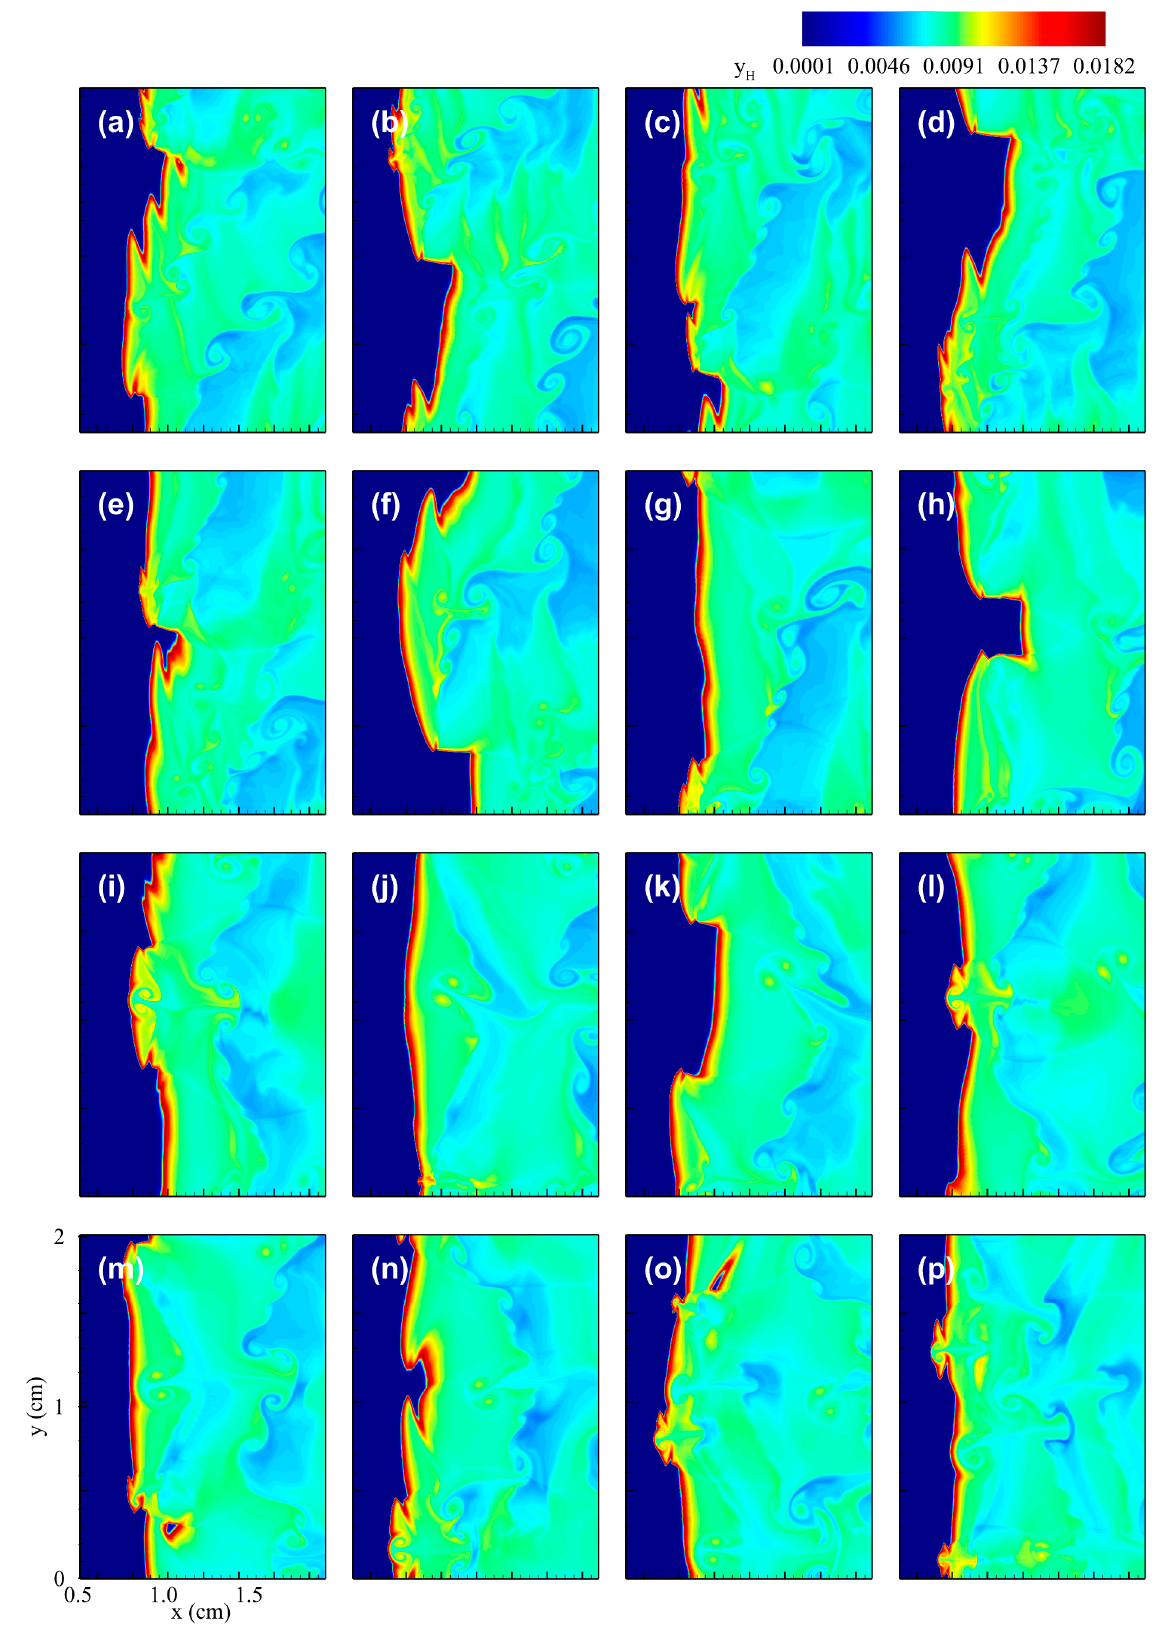
Figure 14. H-radical distribution during the bifurcation process (initiation of the reaction process). The subfigures are plotted in temporal sequence ( a – p ).